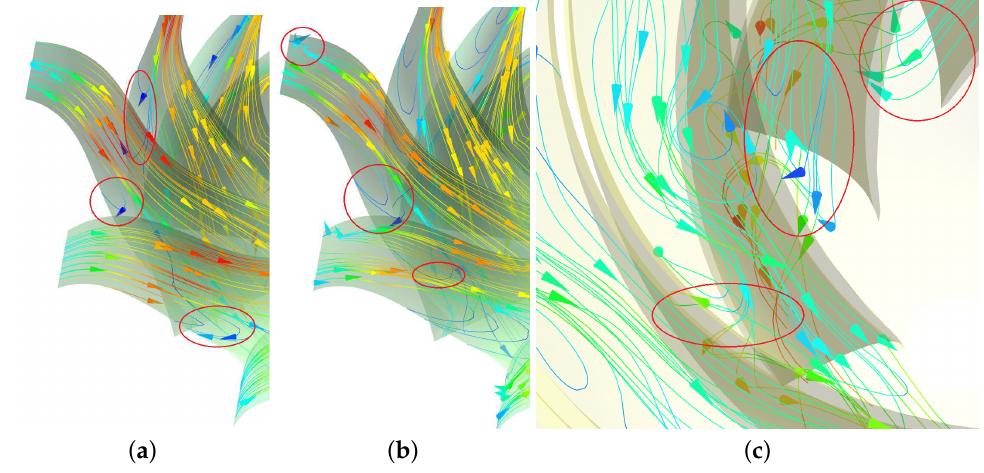
Figure 24. Representations of flow field streamlines on runner passage surfaces at: ( a ) T f = 0.21; ( b ) T f = 0.55; and ( c ) in channels near to trailing edge at T f = 0.71.